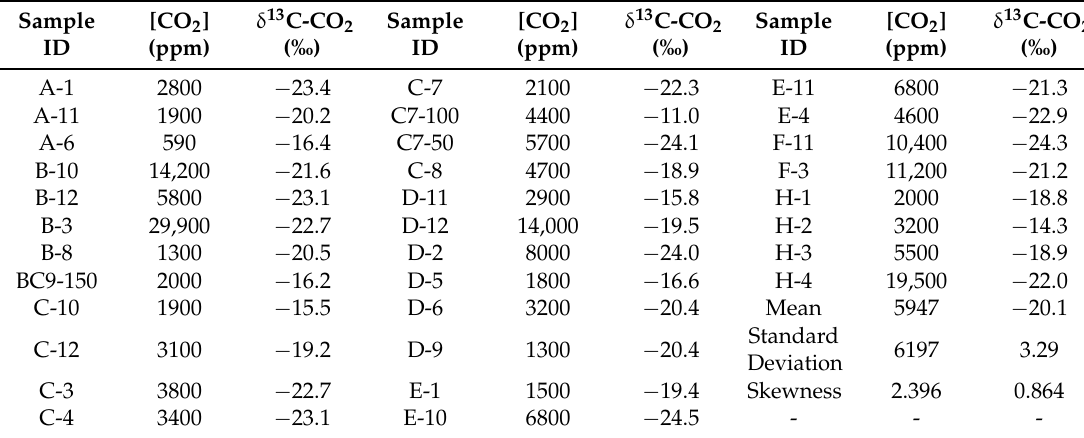
Table 3. Isotope results for Godin site.